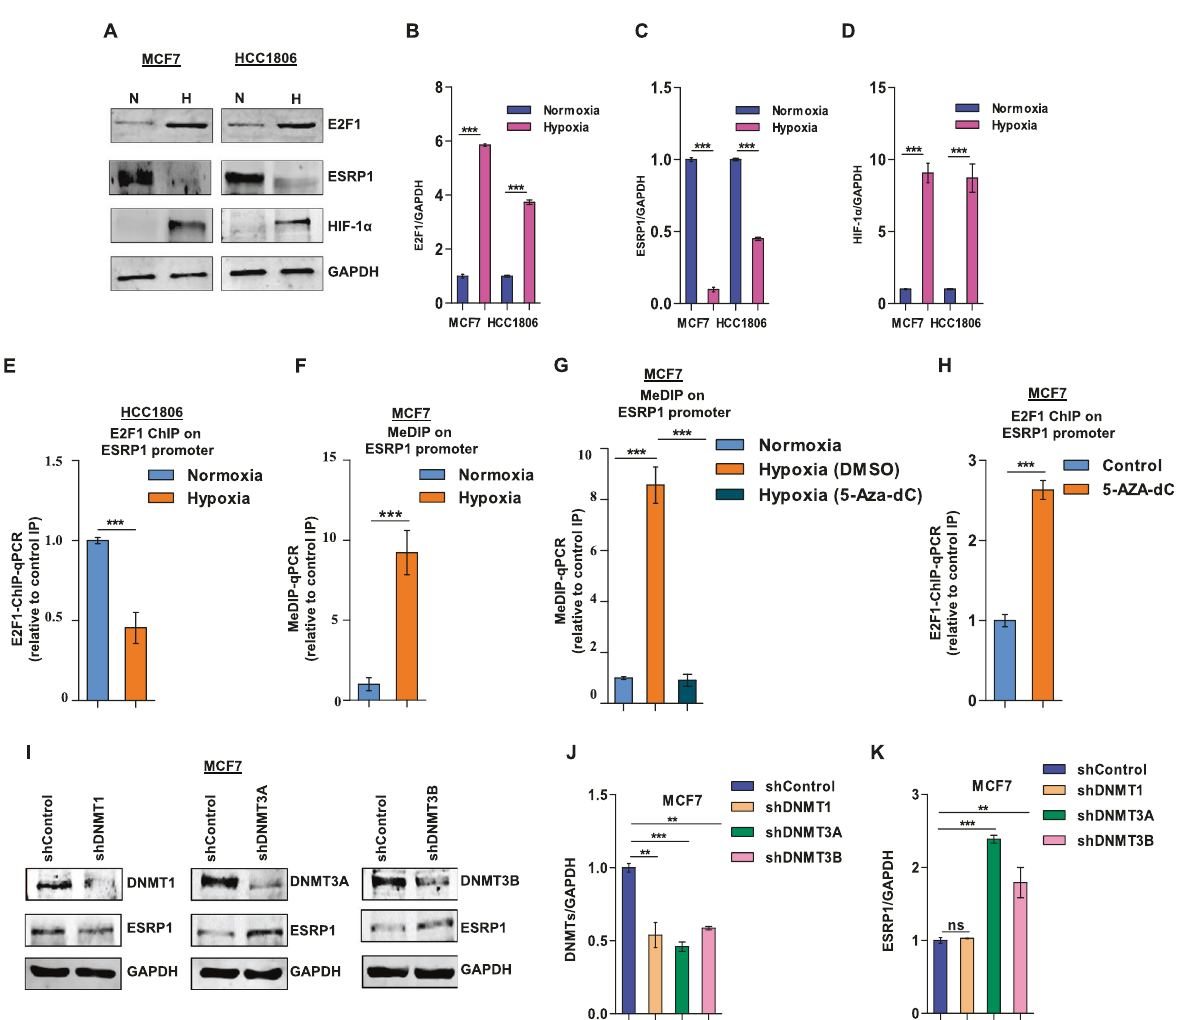
Fig. 3 Hypermethylated binding motif repels E2F1 from the ESRP1 promoter in hypoxic breast cancer increased DNA methylation. A Immunoblots of E2F1, ESRP1, and HIF1 α in MCF7 and HCC1806 cells (Normoxia versus Hypoxia). B – D Densitometric analysis of representative blots. E ChIP qRT-PCR on ESRP1 promoter using E2F1 antibody in HCC1806 cells (Normoxia versus Hypoxia). F MeDIP of DNA isolated from MCF7 cells (Normoxia versus Hypoxia) using 5-methyl-cytosine antibody followed by qRT-PCR, relative to input and control IgG ( n = 3). G MeDIP on ESRP1 promoter using 5-methyl-cytosine antibody after treating MCF7 cells with 5-aza-2 ’ -deoxycytidine under hypoxia followed by qRT-PCR, relative to input and control IgG ( n = 3). H ChIP qRT-PCR on ESRP1promoter using E2F1 antibody in 5-aza-2 ’ - deoxycytidine (10 μ M) treated MCF7 cells under hypoxia. I Immunoblots of DNMT1, DNMT3A, DNMT3B, and ESRP1 protein expression in shDNMT1, shDNMT3A, shDNMT3B, and shcontrol MCF7 cells under hypoxic condition. J , K Densitometric analysis of representative blots compared to shControl normalized to one. Error bars show mean values ± SD ( n = 3 unless otherwise speci fi ed) calculated using two-tailed Student ’ s t test, * *P < 0.01 and ** *P <